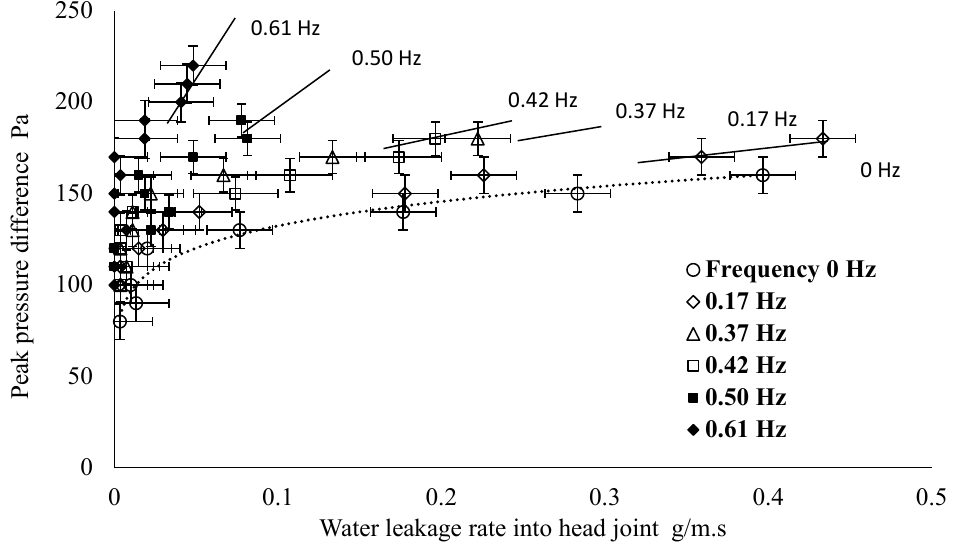
Figure 13. Frequency dependent water leakage into a window head